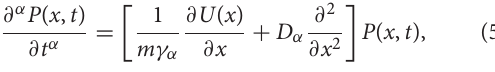
1 for BD and γ 10 − 3 = = 1 for =